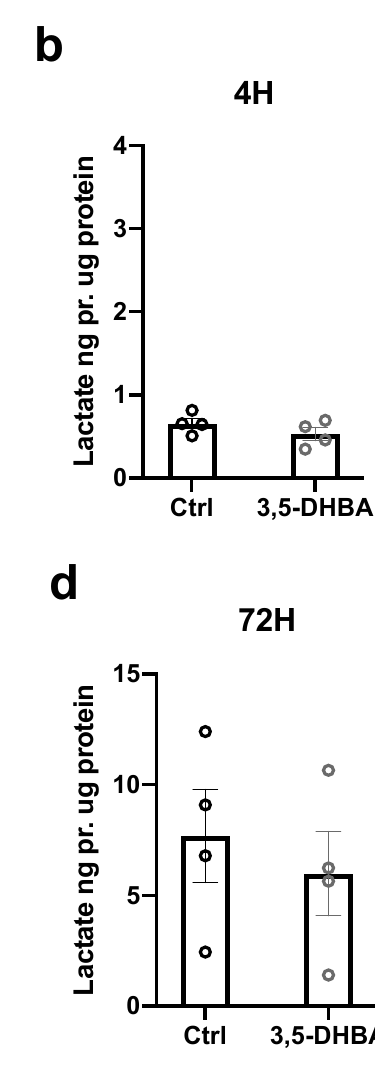
Figure 4. Extra-retinal lactate levels in retinal explants are decreased in response to 3,5-DHBA treatment. ( a – d ) The extra retinal concentrations of lactate measured in retinal explants incubated for 2, 4, 24, and 72 h. Lactate levels decrease during 2 and 24 h of incubation with 3,5-DHBA compared to controls. Values are normalized to mg of protein in each sample. Values are presented as mean ± S.E.M ( n = 4 retinal quarters originating from four different whole retinas). Statistics: Unpaired t -test.